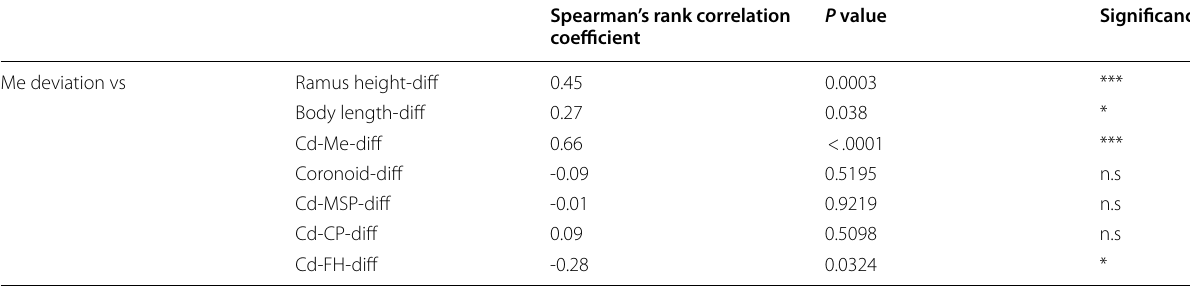
Table 6 Results of correlation between Me deviation and each analysis